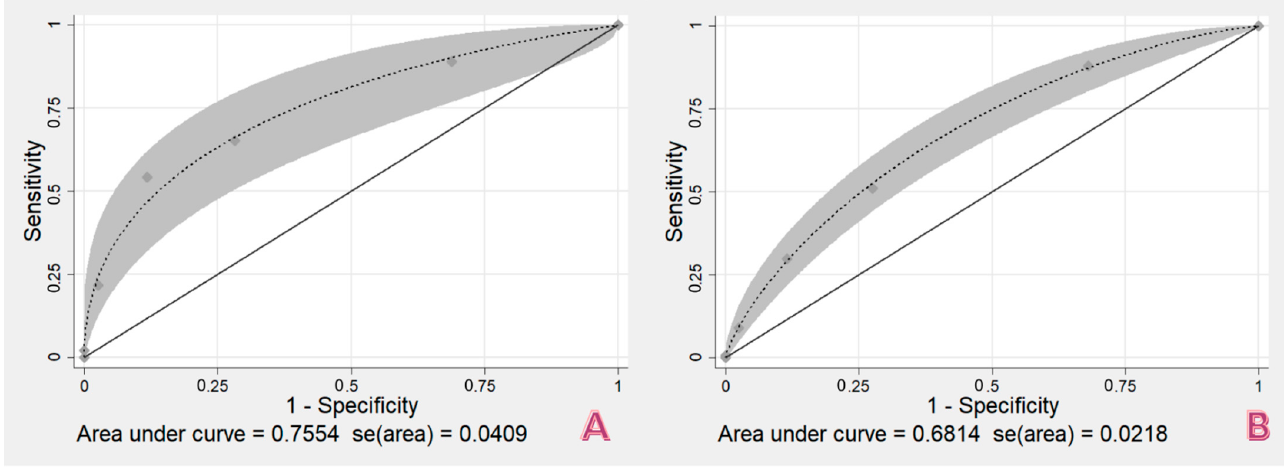
Figure 4. The area under ROC curve of TERMINAL-24 score in ( A ) death within 8 h and ( B ) death within 24 h.